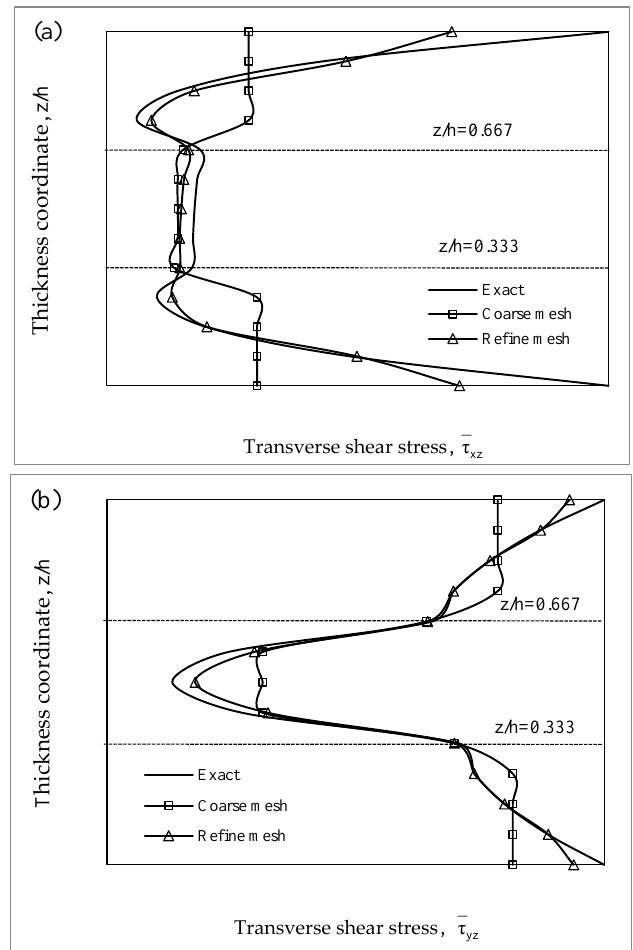
Figure 3. Nondimensionalized transverse shear stress distributions through the thickness of a square laminates ( a = 3 mm, S = 4): ( a ) τ xz ; ( b ) τ yz .